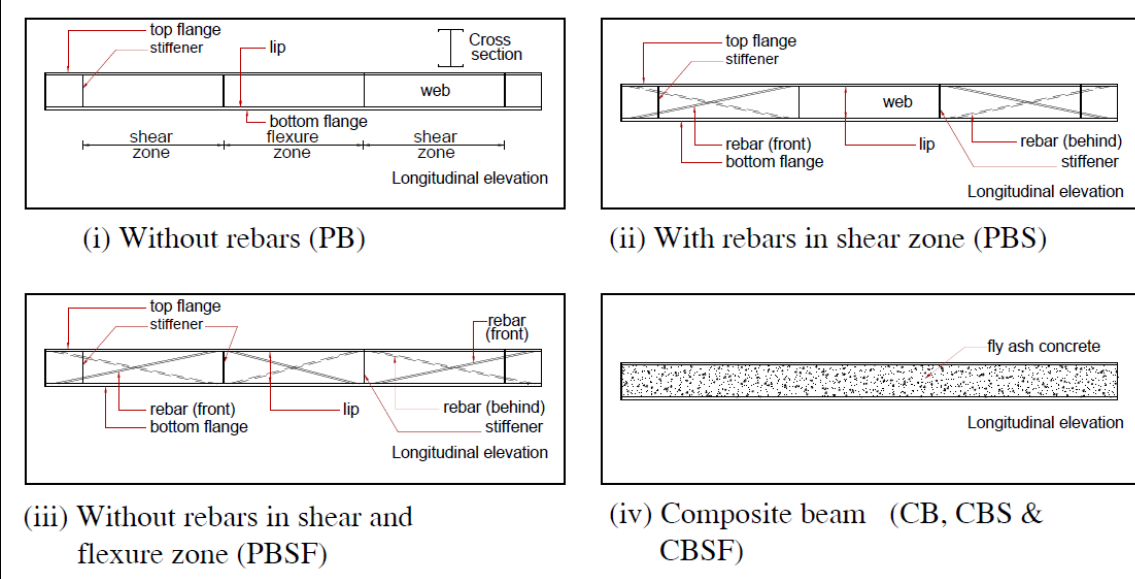
Figure 2. Schematic diagrams of CFS beams.